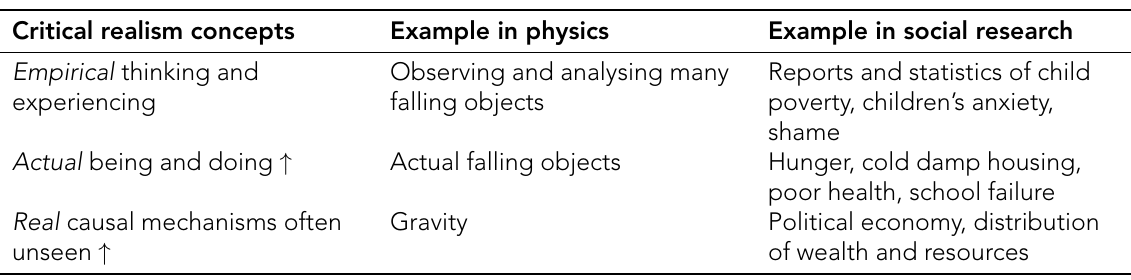
Table 1. Three levels of reality (Source: